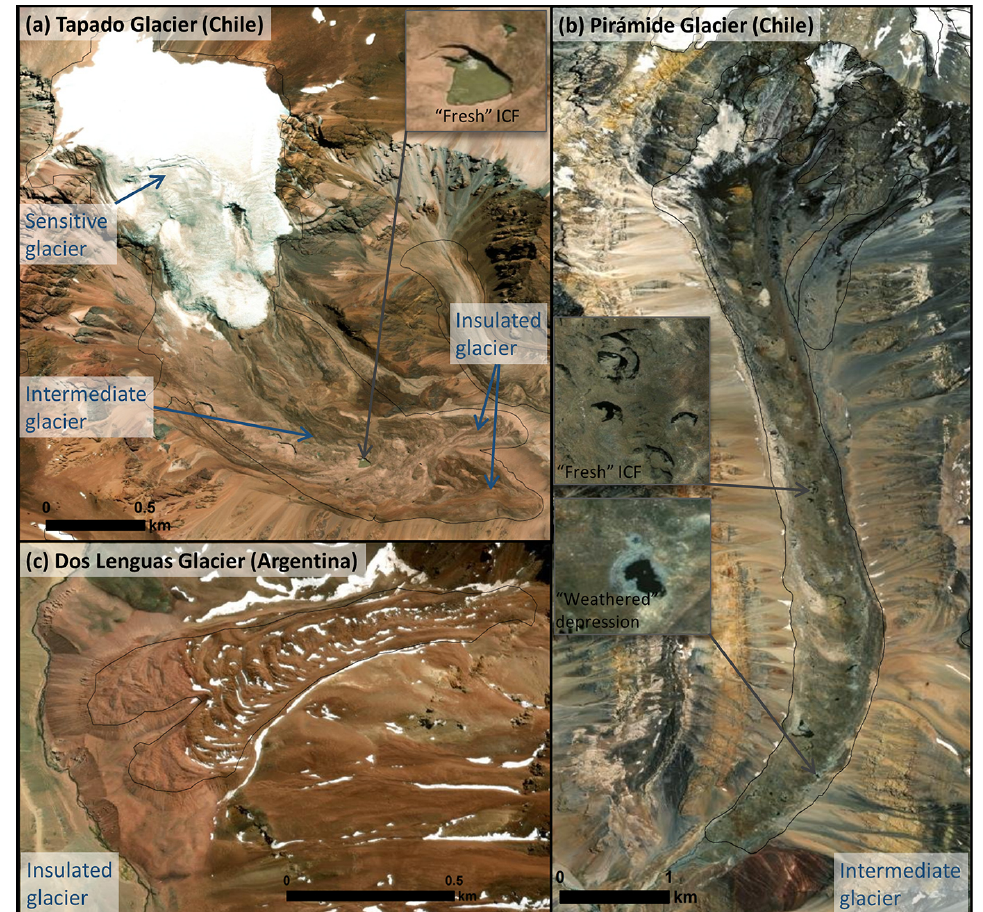
Figure 1. Three glaciers in the semiarid Andes for which the glacier type (sensitive, intermediate, or insulated) is clearly identifiable based on the geomorphological criterion presented in this paper are shown. Tapado Glacier is made up of the three distinct glacier types proposed in this study. Approximately 95% of the surface of Pirámide Glacier is covered by debris, and there are numerous thermokarst depression features, so it is classified as an intermediate glacier. Dos Lenguas Glacier does not have ice exposed at the surface, has convex topography accentuated with ridges and furrows, and has an obvious frontal slope, so it is classified as an insulated glacier. Image source (Esri basemap): (a) 11 March 2019 GeoEye (0.46m), (b) 18 January 2013 WorldView-2 (0.5m), (c) 17 September 2017 WorldView-2